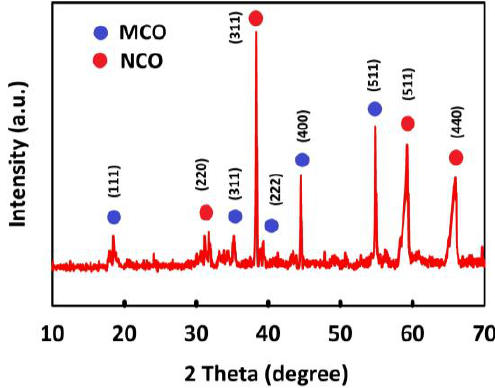
Figure 1. XRD patterns of MnCo 2 O 4 /NiCo 2 O 4 .